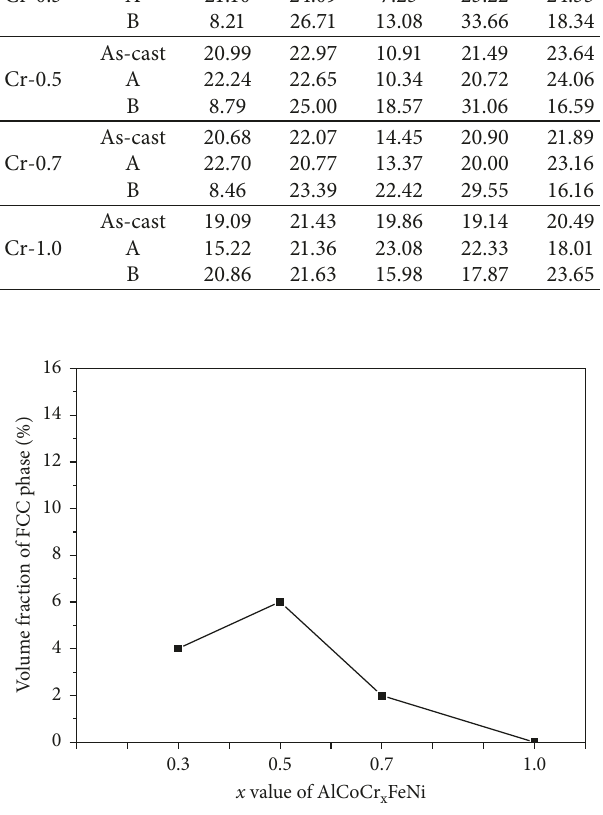
Figure 3: Variation in volume fraction of FCC phase for the AlCoCr x FeNi alloys.